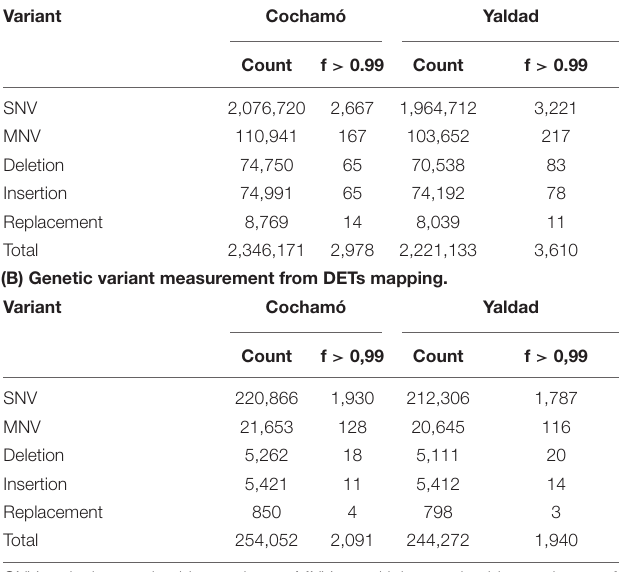
TABLE 2 | Genetic variant detected in assemblies of Cochamó and Yaldad, mapped over (A) the reference library and (B) selected differential expressed transcripts